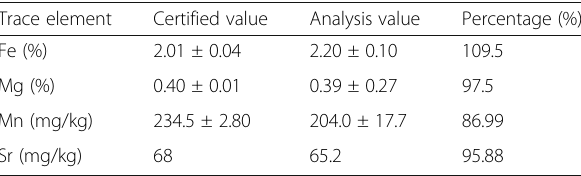
Table 1 The value of accuracy analysis for standard reference